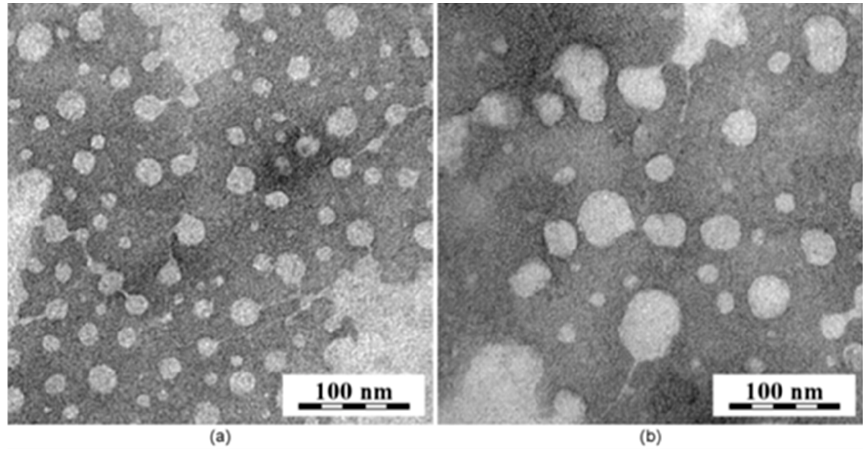
Figure 5. TEM images of MPEO 44 - b -PCL 17 at pH ~ 7.4 ( a ) and pH ~ 5.0 ( b ) after 48 h incubation. The release profile of the chemotherapeutic PTX was explored towards mimicking the target acidic environment in endosomal and lysosomal compartments (pH ~5.0, 37 ◦ C) (Figure 6). Furthermore, to simulate physico-chemical conditions during transport in the blood and in normal healthy tissues, the release experiments at pH ~7.4 and 37 ◦ C were also performed, as well (Figure 5). The obtained results suggest that the acid pH accelerates the release of the drug from the NPs, most likely due to the NPs physical destabilization (pH- triggered disassembly-aggregation, Figure 3). The drug cargo was released almost twice as efficiently (~70% released) within 48 h at pH ~5.0 (mimicking intracellular environment) than at physiological conditions of pH ~7.4. On the other hand, at pH ~7.4, only ~36% of the drug-loaded into the NPs cores was released.